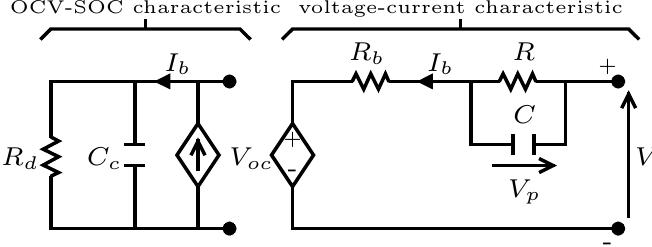
Figure 1. Electric circuit of a lithium battery. OCV : open-circuit voltage; SOC : state of